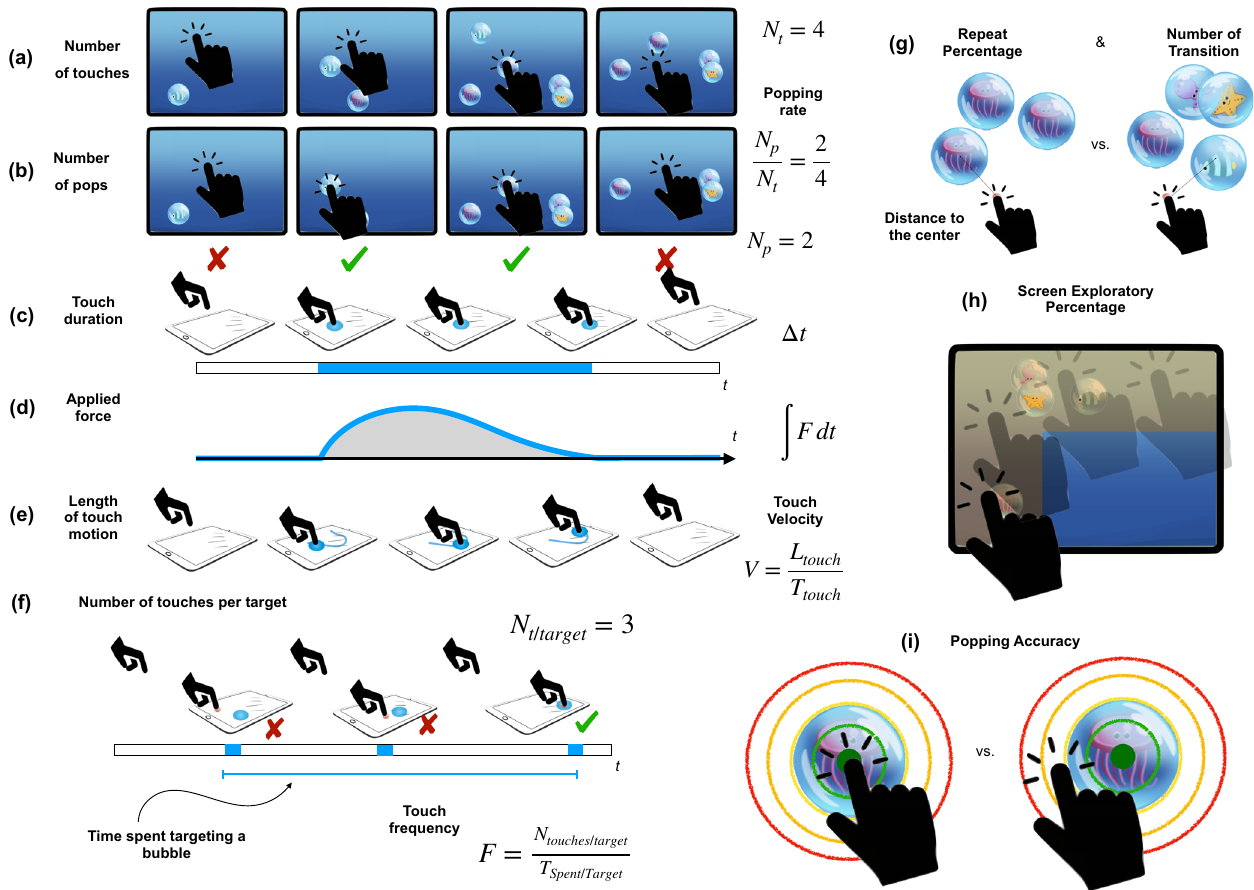
Fig. 7 Illustration of the bubble popping game and the touch-based features extracted. This game is composed of 5 vertical tracks with bubbles appearing from the bottom and moving upwards. Any time a bubble is touched, the bubble pops, making a distinct popping sound releasing a cartoon animal character inside the bubble. When the bubble is popped, it appears again (same cartoon character) from the bottom of the same lane, otherwise a random one appears after the bubble exits the screen from the top. a – i graphically represent many of the touch-based features extracted from the game (see